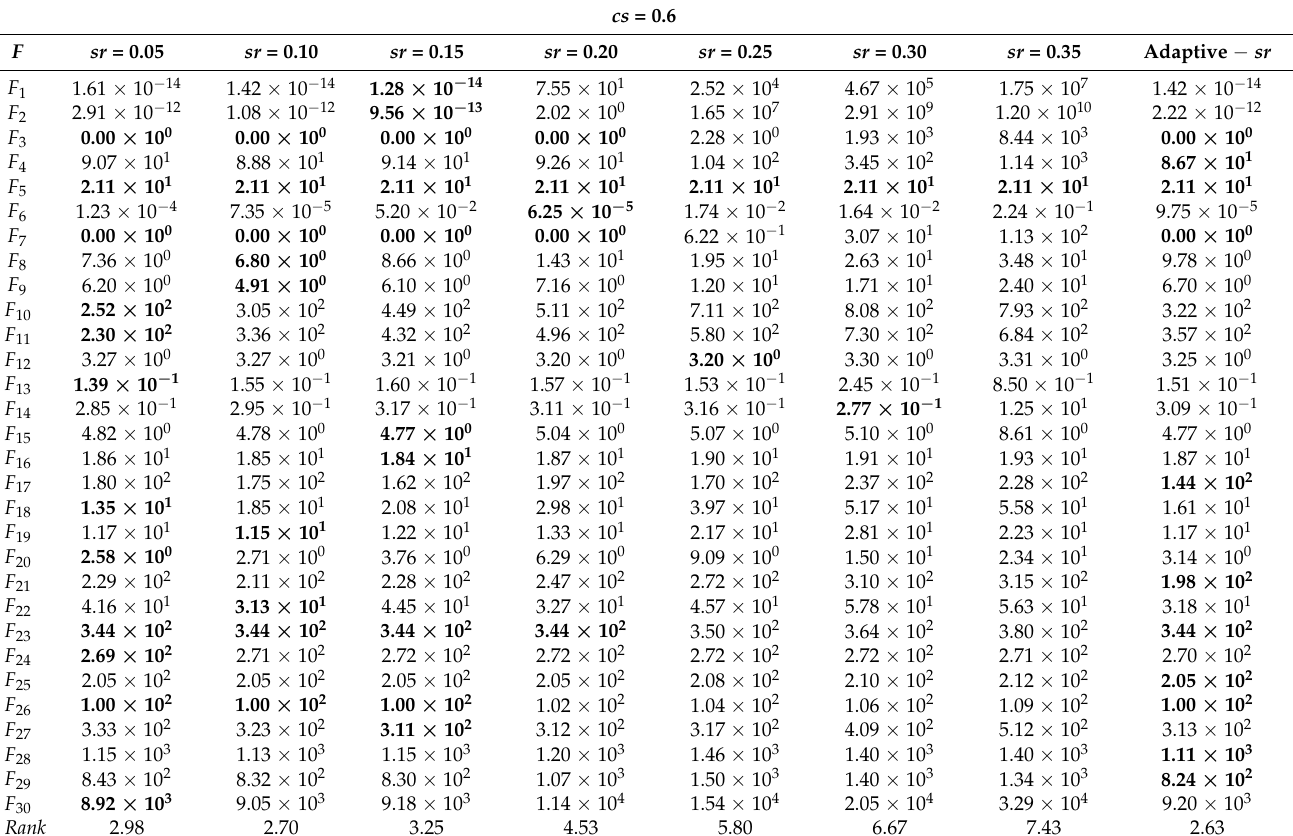
Table 7. Comparison between ACSEDA, with and without the adaptive promising individual selection method, on the 50- D CEC 2014 benchmark problems. The best results are highlighted in bold in this table. cs =